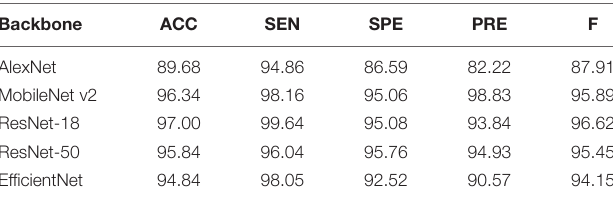
TABLE 4 | Performance of the PBTNet with different backbones based on 5-fold cross-validation (unit: %).